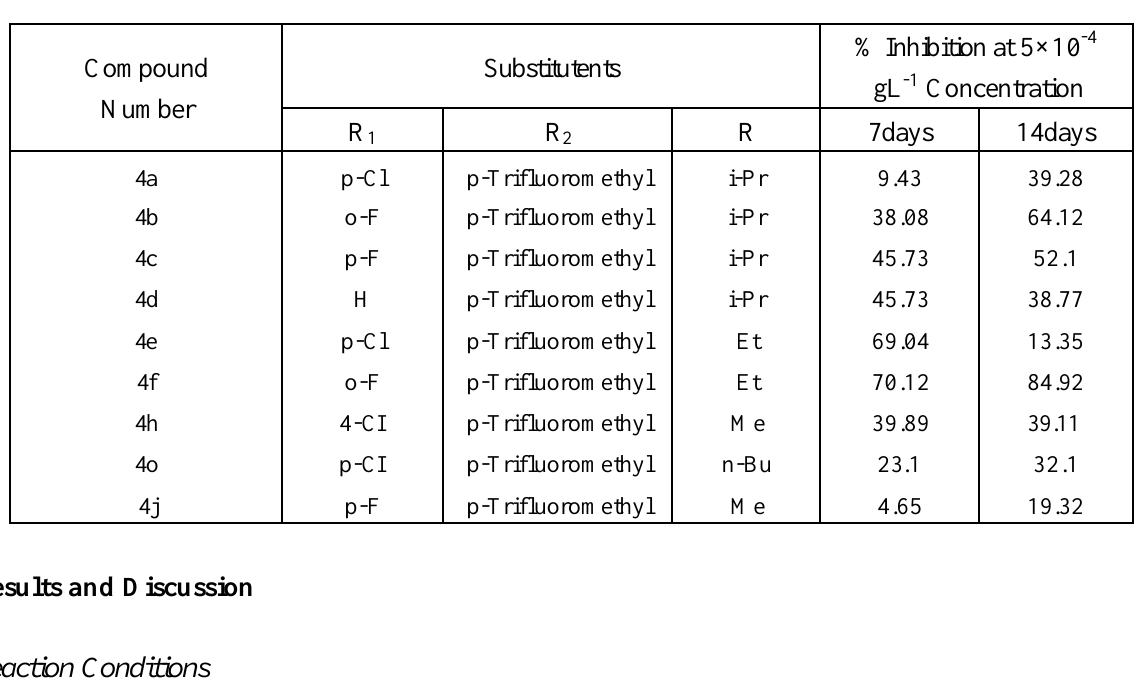
Table 1. The anti-TMV bioactivity of some synthesized compounds in the